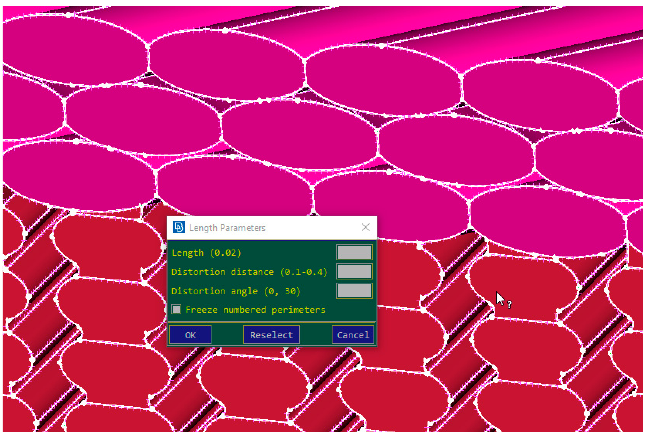
Figure 9. Setting the Perimeter Length to a value that allows a precise representation of the layers.